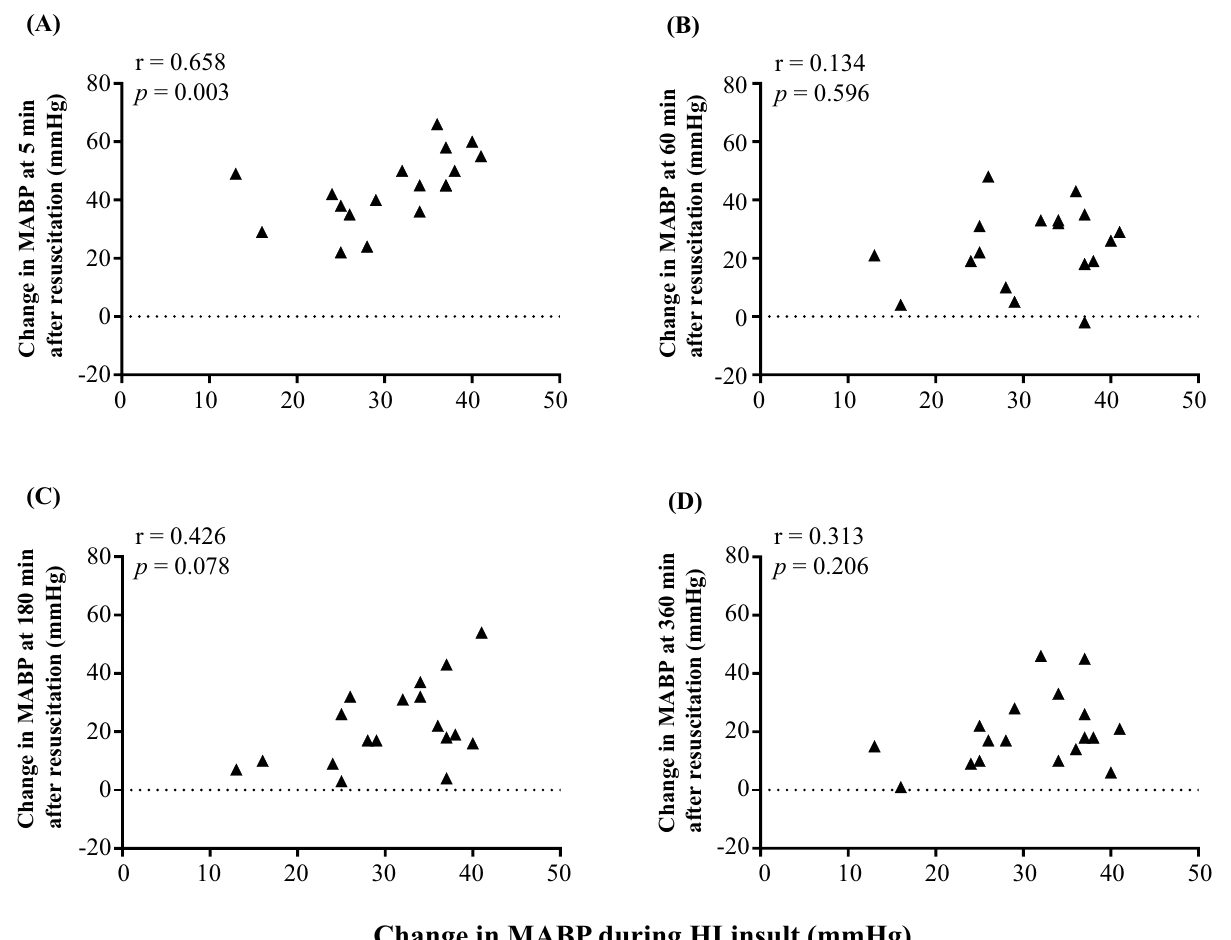
Figure 2. Correlation between changes in MABP during insult and changes in MABP at ( A ) 5 min, ( B ) 60 min, ( C ) 180 min, and ( D ) 360 min after insult. MABP changes were defined as the differences between the MABP value at the maximum CBV during insult and the MABP values 5, 60, 180, and 360 min after